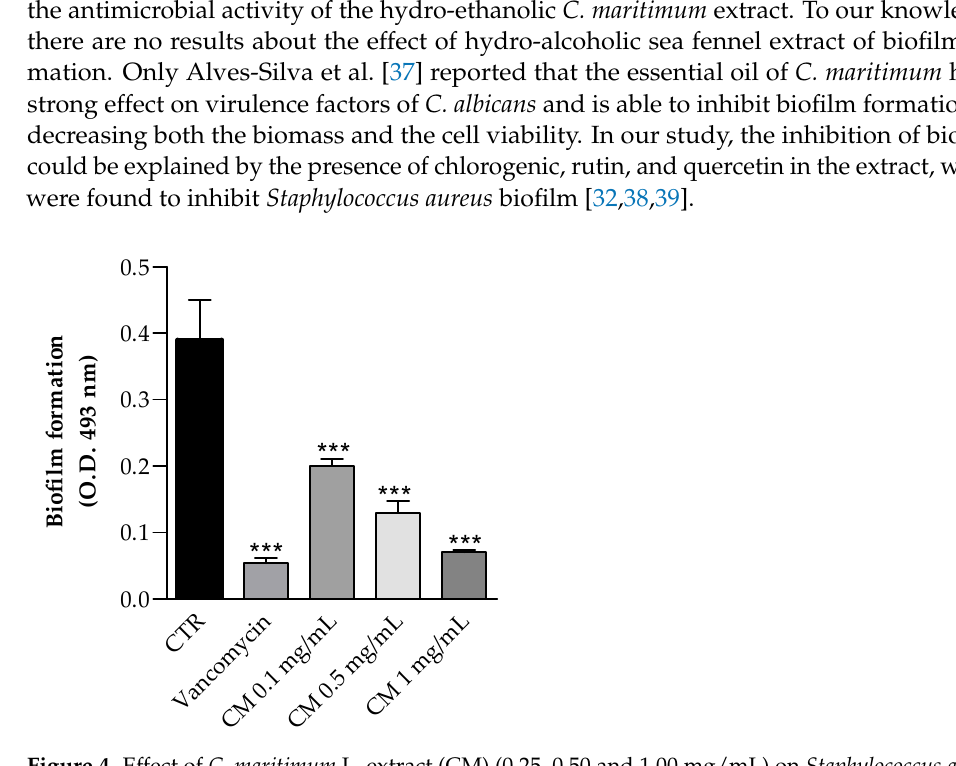
Figure 4. Effect of C. maritimum L. extract (CM) (0.25, 0.50 and 1.00 mg/mL) on Staphylococcus aureus (ATCC 35556) biofilm formation. Results are reported as means values ± standard deviation ( n = 3). *** Highly significant difference from negative control (CTR) ( p ≤ 0.001).